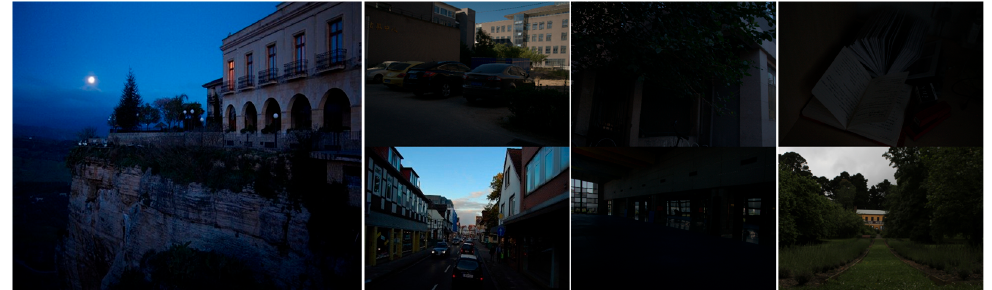
Figure 1. Examples of low-illumination images.